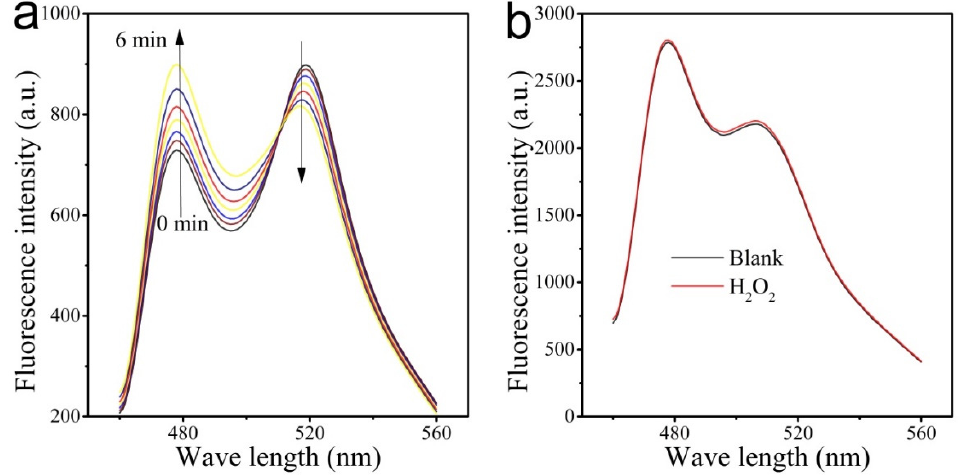
Figure 3. Confirmation of disulfide bonds formation as the mechanism of H 2 O 2 induced FRET in CFP-Prx / mTrx-YFP system (CPmTY). ( a ) Fluorescence spectrum variation in 6 min when excess amount of DTT was added after CPmTY reaction with and H 2 O 2 . ( b ) Fluorescence spectra of CFP-Prx / wtTrx-YFP (wild-type Trx that retained the resolving cysteine residue, C39) mixture in the absence (black line) and presence (red line) of abundant H 2 O 2 .